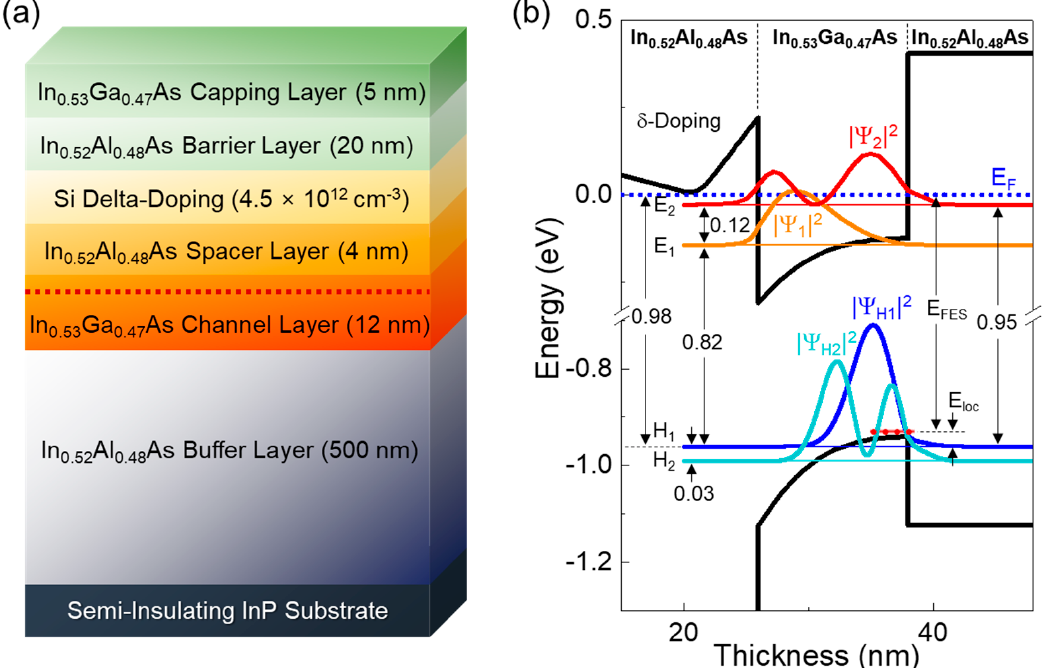
Figure 1. ( a ) Schematic of the In 0.53 Ga 0.47 As/In 0.52 Al 0.48 As quantum well (QW) structure. ( b ) Energy band profile of the In 0.53 Ga 0.47 As/In 0.52 Al 0.48 As QW structure calculated by Schrödinger-Poisson equations. The symbols of “| Ψ 1 | 2 and | Ψ 2 | 2 ” and “| Ψ H1 | 2 and | Ψ H2 | 2 ” in ( b ) denote the squared envelope functions for electrons and holes, respectively, at the quantum confined energy states. Next, the Si delta-doped sheet (4.5 × 10 12 cm − 2 ) and the undoped In 0.52 Al 0.48 As barrier layer (20 nm) were sequentially grown on the spacer layer. Finally, the 5-nm-thick cap layer of